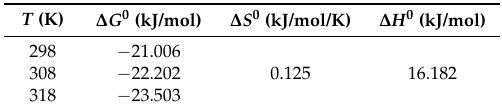
Table 3. Thermodynamic parameters of Cd(II) adsorption on Mn oxide.